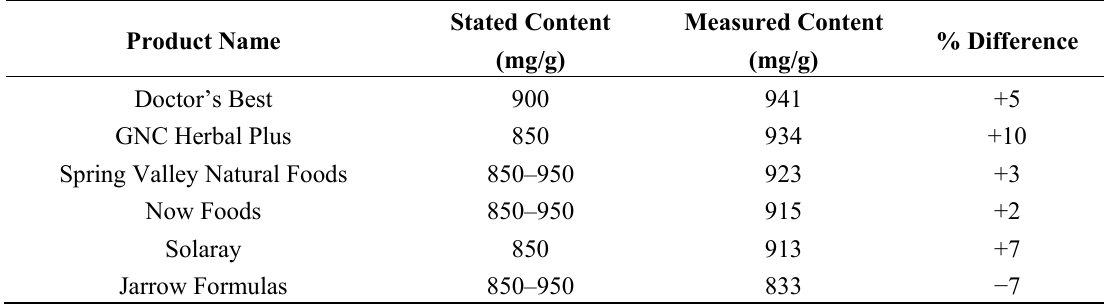
Table 6. Stated, measured, and percentage difference in total fatty acid content in liquid saw palmetto